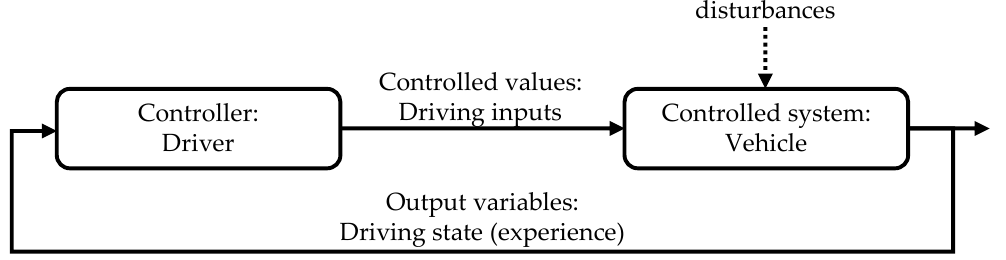
Figure 2. Conventional control loop of the driving guidance, adapted from [14].